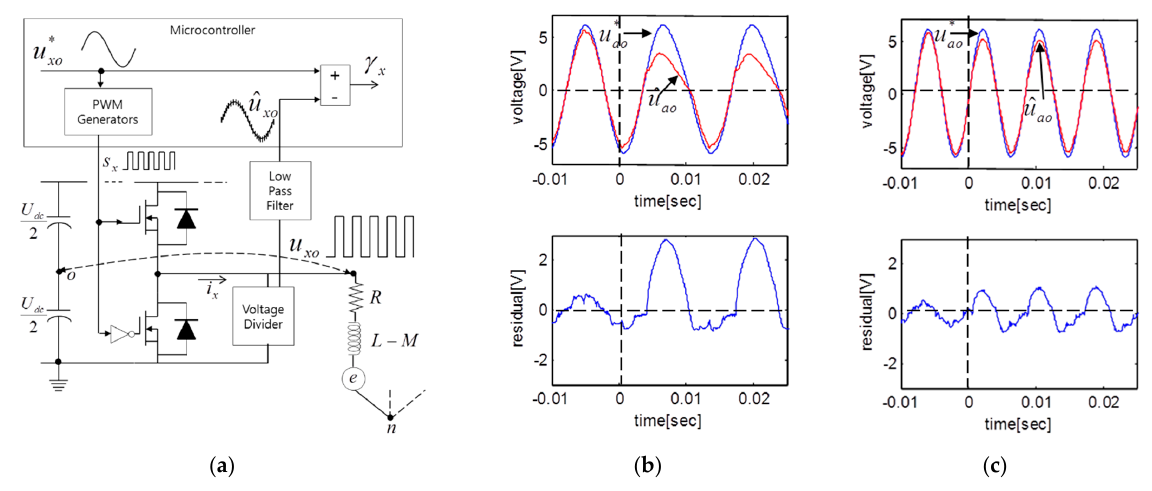
Figure 12. Voltage measurement-based open-switch fault detection: ( a ) detection concept; ( b ) detection results at higher load conditions; and ( c ) detection results at lighter load conditions. Table 2. Parameters and specifications of an AC drive system.